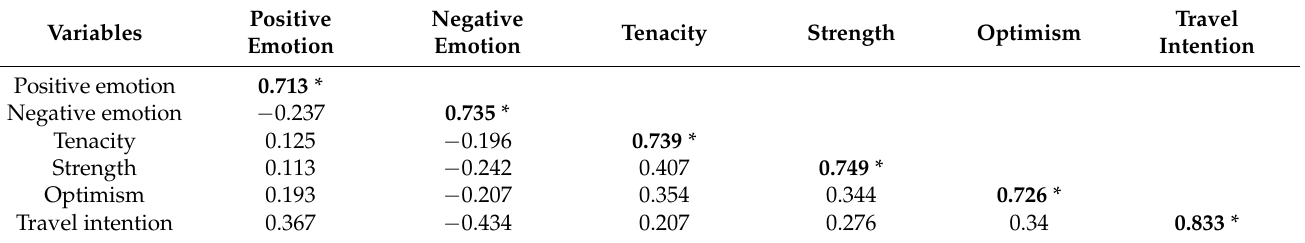
Table 3. Discriminant validity and the correlations of